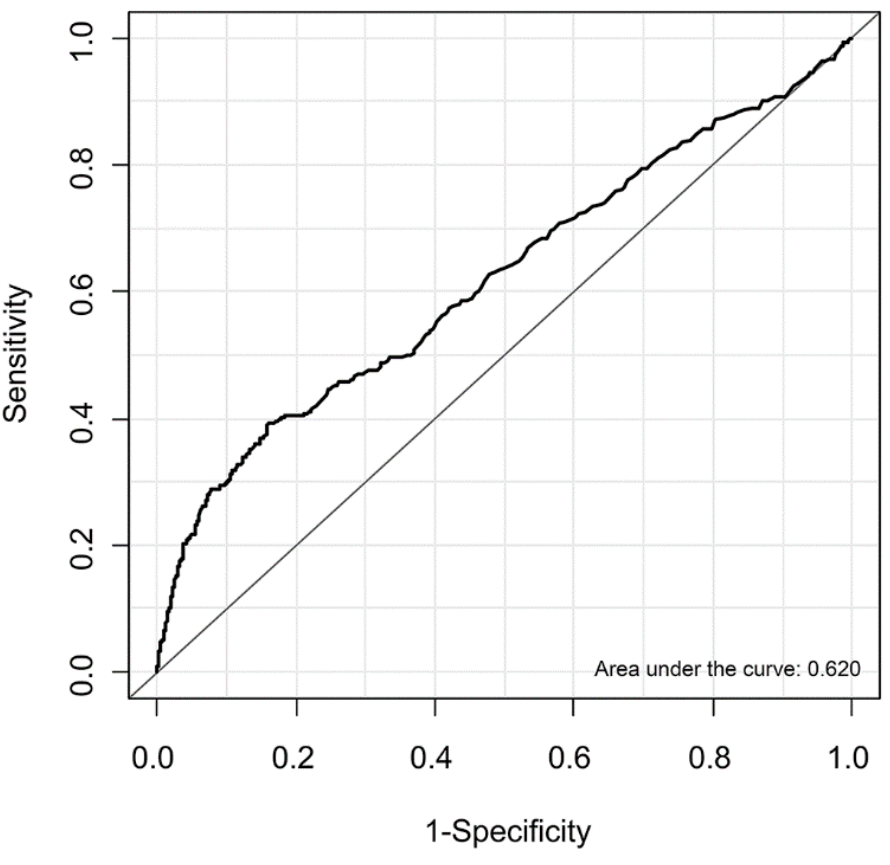
Figure 3. Receiver operating characteristic curves of the entire population for intraoperative lactate concentration associated with myocardial injury after noncardiac surgery.